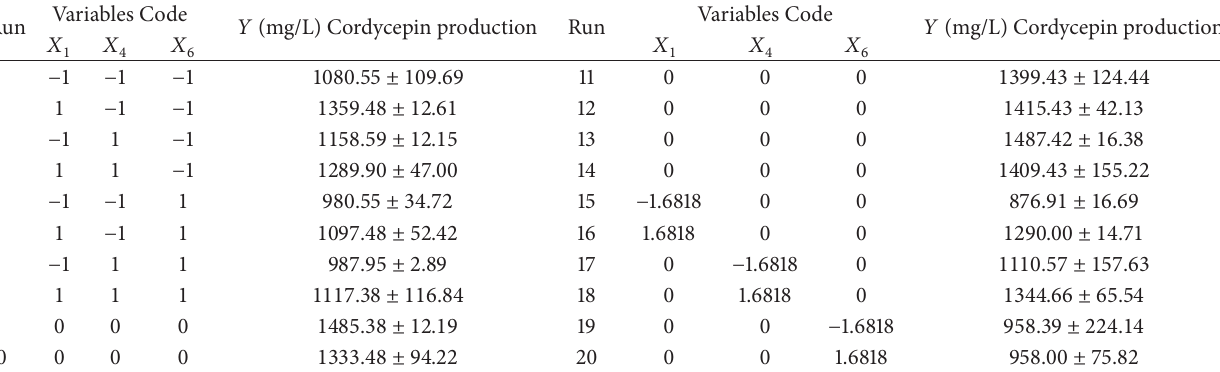
Table 6: Experimental design and responses of the central composite design for carbon sources and inorganic salts. Variables Run